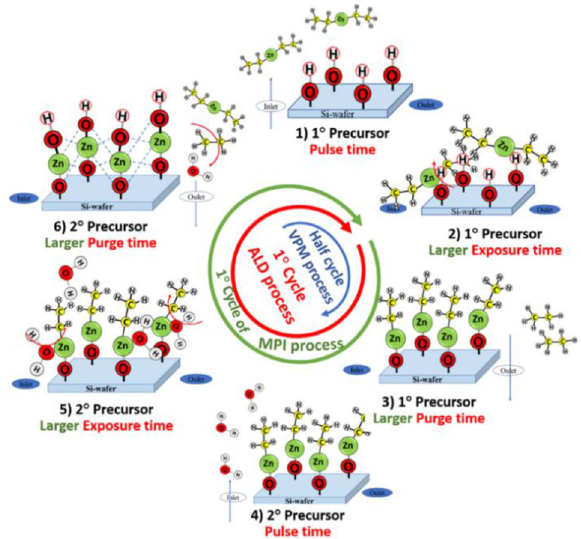
Figure 1. Scheme for the synthesis of zinc oxide by atomic layer deposition (ALD). (1) Diethylzinc (DEZ) pulse injection, (2) chemisorption of DEZ upon the Si wafer surface, (3) purge of unreacted DEZ and by-products, (4) H 2 O pulse injection, (5) reaction of water with absorbed DEZ, and (6) purge of excess H 2 O and